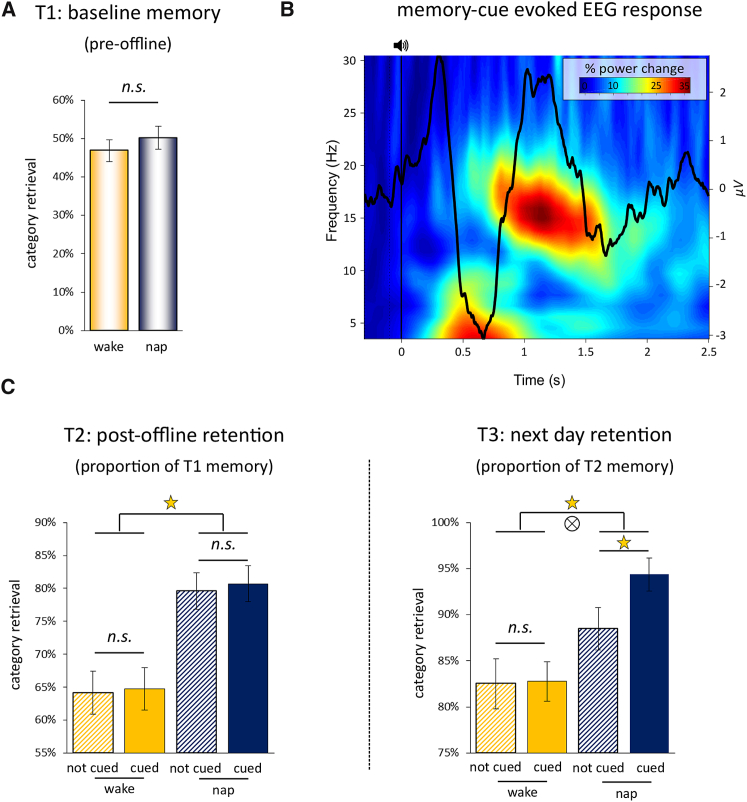
Behavior and Evoked Responses(A) Behavioral results at T1 (pre-offline period). Bar graphs show mean (±SEM) accuracy for adjective-category retrieval for the nap group (blue) and the wake group (orange). Note that 50% accuracy is not to be mistaken as chance performance given that participants had a “?” response option (see Figure 1A).(B) Event-related potential (ERP) and time-frequency representation (TFR) evoked by the onset of memory cues. The figure depicts the unthresholded TFR along with the grand average ERP (both collapsed across all channels and then averaged across participants), revealing a strong increase of theta/slow spindle power in the evoked SO down-state followed by an increase in fast spindle power in the ensuing SO up-state. ERP topographies for object, scene, and control stimuli are shown in Figure S1.(C) At T2 and T3, behavioral results are further separated into cued trials (solid fill) and not cued trials (hatched fill), and retrieval accuracy is expressed as proportions retained from the most recent memory assessment (see also Table S2). Stars denote significant effects, ⊗ denotes an interaction effect.